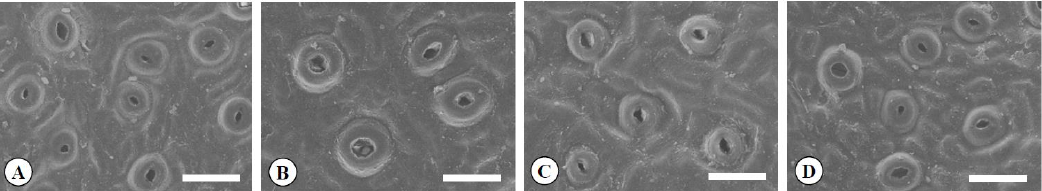
Figure 4. Scanning electron micrographs of guard cells in the diploid ( A ), the tetraploid ( B ), the Yubeni ( C ), and the chimera ( D ) of the Meiwa kumquat. Bars = 30 μm.